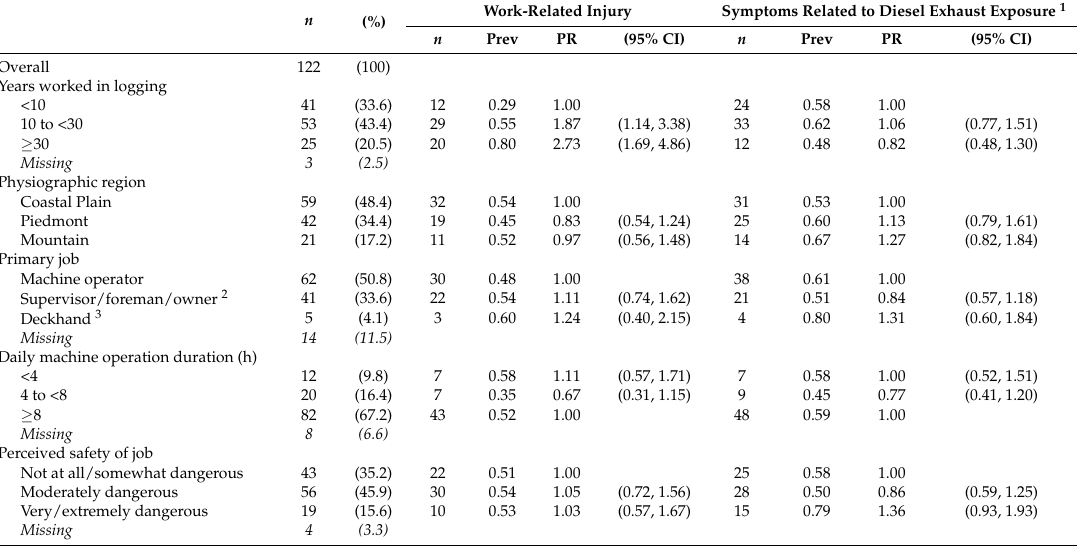
Table 1. Career prevalence, prevalence ratios (PR) and 95% confidence intervals (CI) of work-related injury and symptoms related to diesel exhaust exposure among a sample of loggers in Virginia,